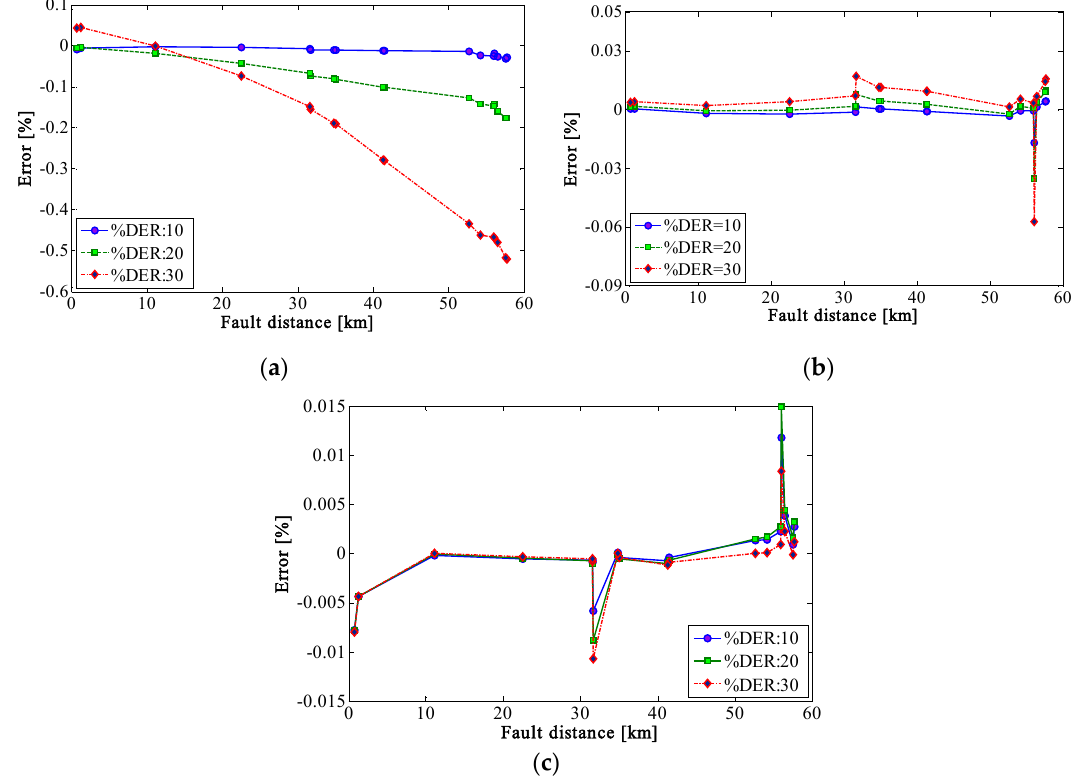
Figure 14. Performance curve for Scenario 3: ( a ) using the synchronous machine model, ( b ) using the Inverter-interfaced DER model in limiting current mode, and ( c ) using the IEDs information.